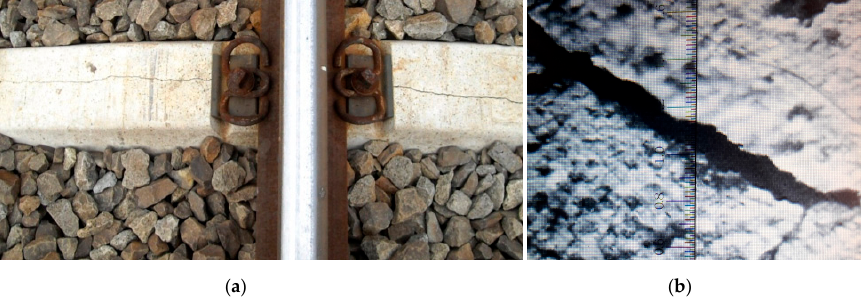
Figure 16. Detail of the cracked sleeper on the Brazilian railway: ( a ) sleeper with crack in the support; and ( b ) crack detail with laser fissurometer.